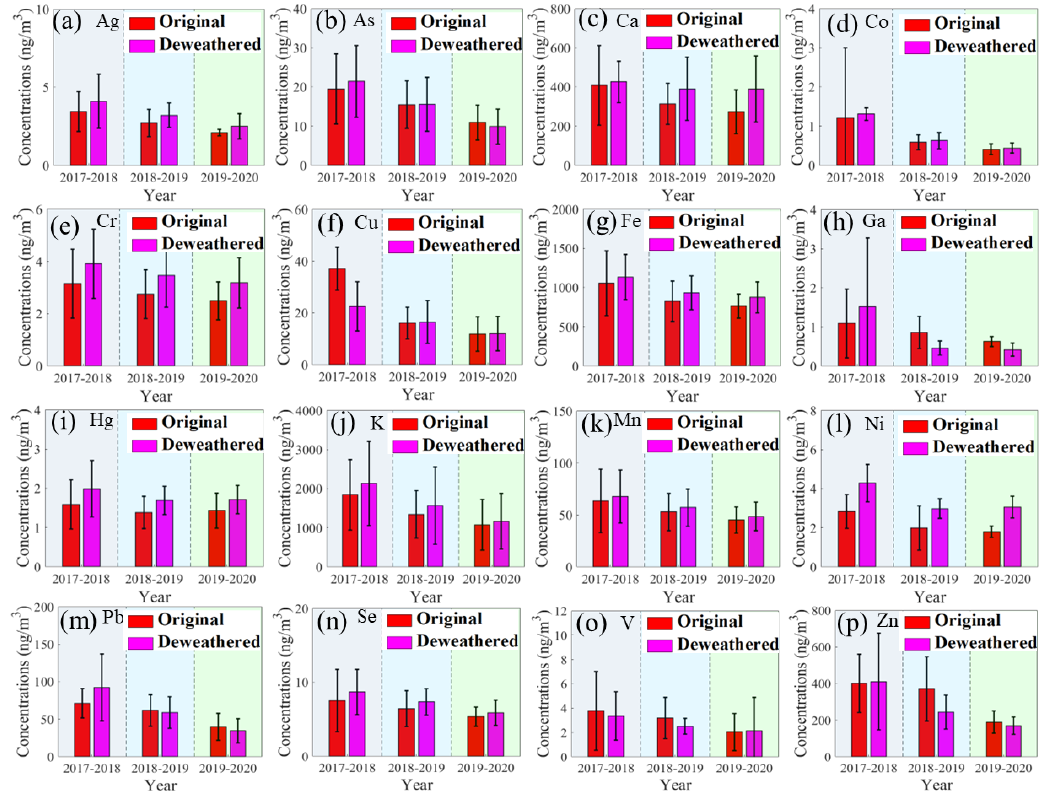
Figure 3. Interannual variations of the original (red) and deweathered (manganese purple) element concentrations (ngm − 3 ) in PM 2 . 5 in Tangshan. The dark nattier blue and nattier yellow backgrounds represent the species during 2017–2018 (from September in 2017 to August in 2018), 2018–2019 (from September in 2018 to August in 2019), and 2019–2020 (from September in 2019 to August in 2020). The bars and black lines represent mean values and associated standard deviations,